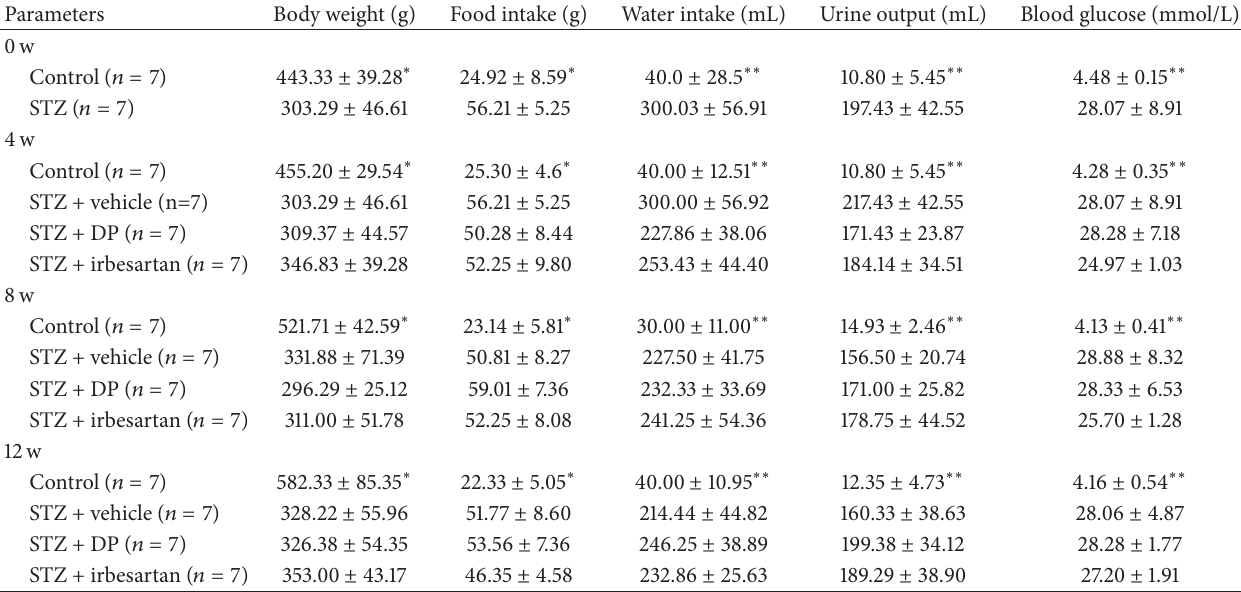
Table 2: Metabolic effects of STZ-induced diabetes and treatments in rats.